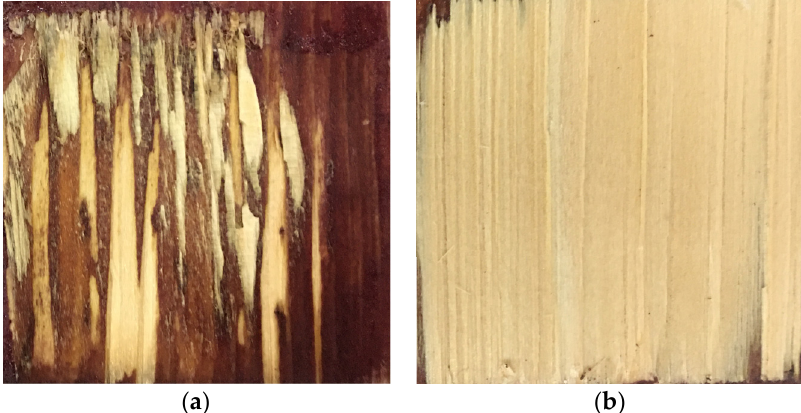
Figure 14. WFSI type. ( a ) Images that take a long time; ( b ) Images that take less time.